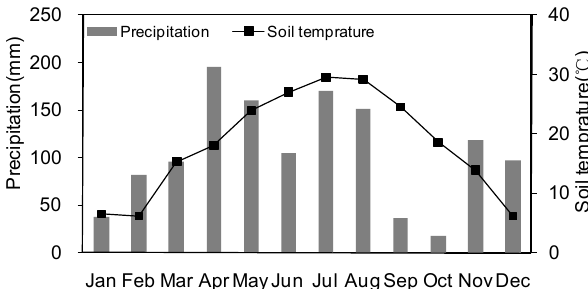
Figure 1. Mean monthly soil temperature and precipitation in the study area during